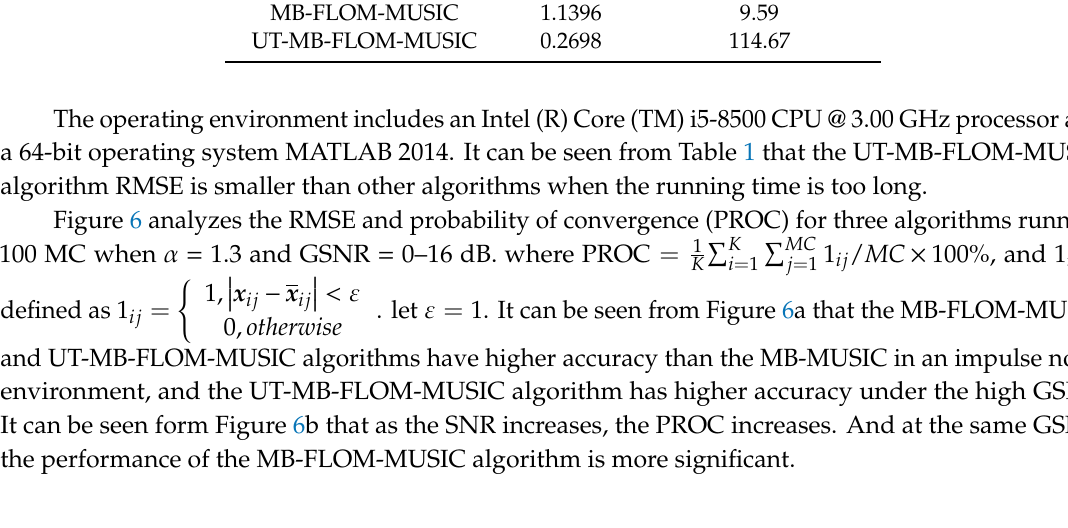
Table 1. Running Time (CV model).